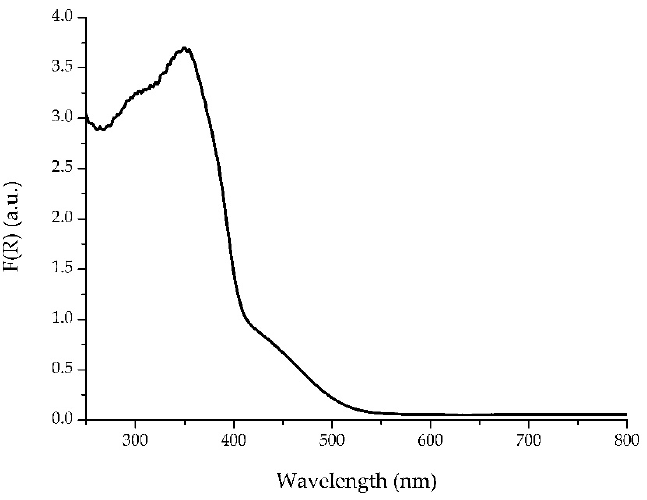
Figure 4. Reflection F(R) to wavelength (nm) graph for N-doped TiO 2 powder.